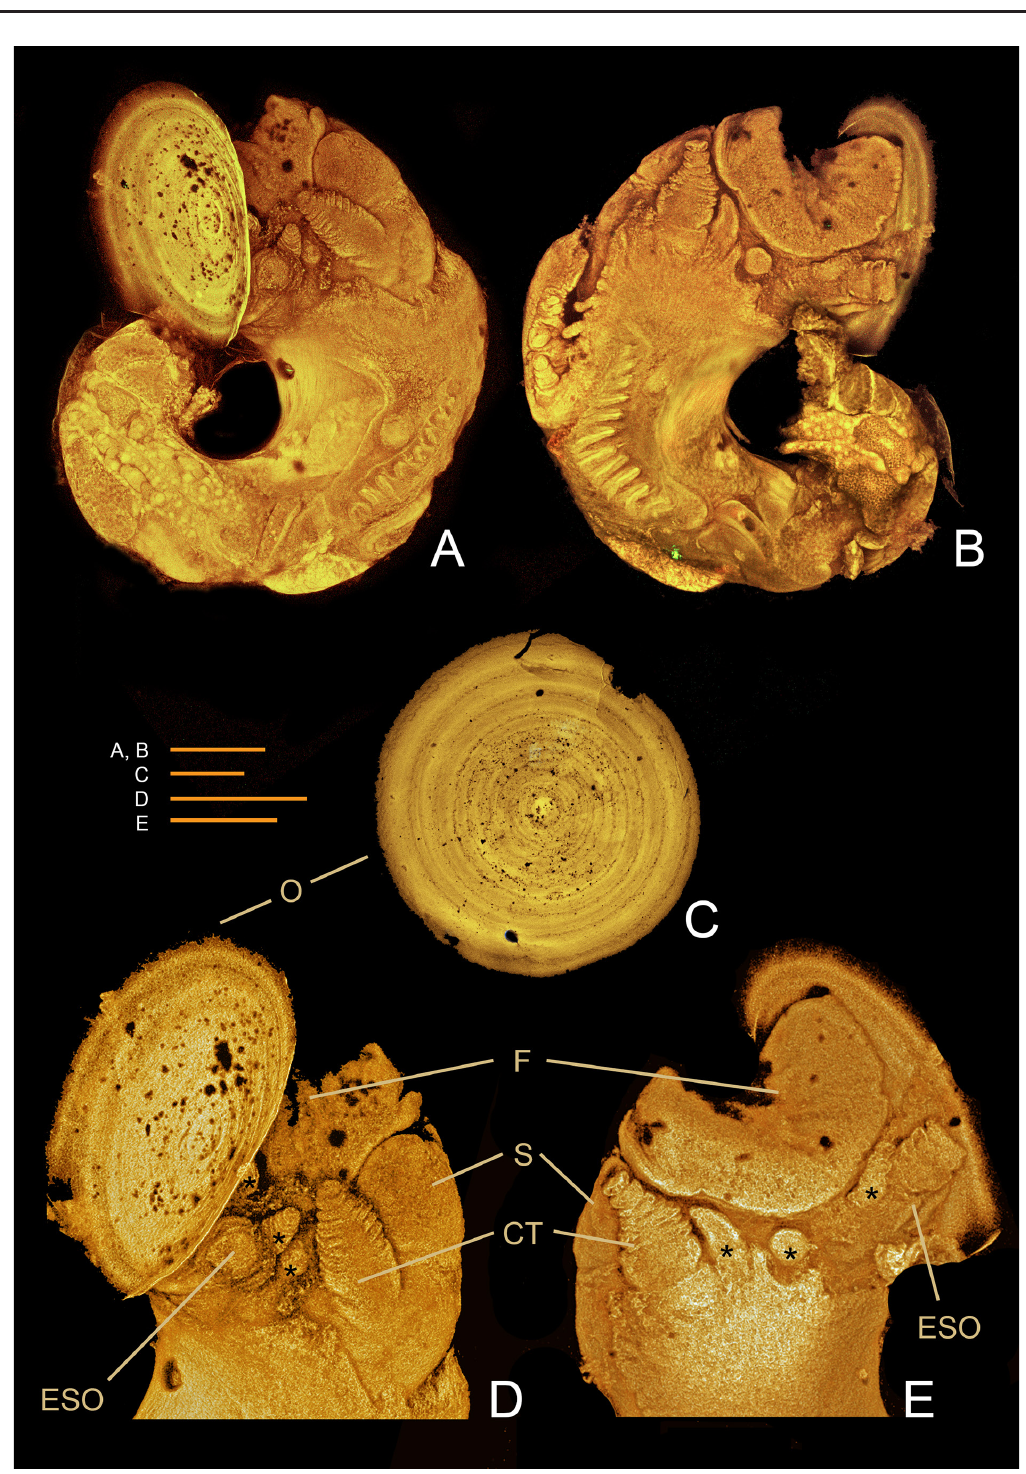
Fig. 6. CLSM images of soft parts of Anatoma declivis sp. nov., South-East Indian Ridge, INDEX19_127RO, (I19_Ma_78). A–B . Soft parts in basal and left anterior view (A) and apical and right-anterior view; internal tip removed (B). C . External view of operculum. D . Left anterior view showing cephalic tentacle (CT), epipodial sensory organ (ESO), epipodial appendage (*), foot (F), operculum (O) and snout (S). E . Right view of anterior with same parts as in D. Scale bars: A–B = 0.2 mm; C = 0.15 mm; D–E = 0.4